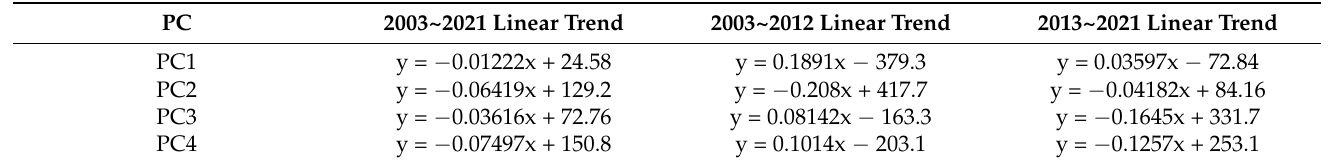
Table 2. The overall trend line of PC value in 19 years and the trend line of each